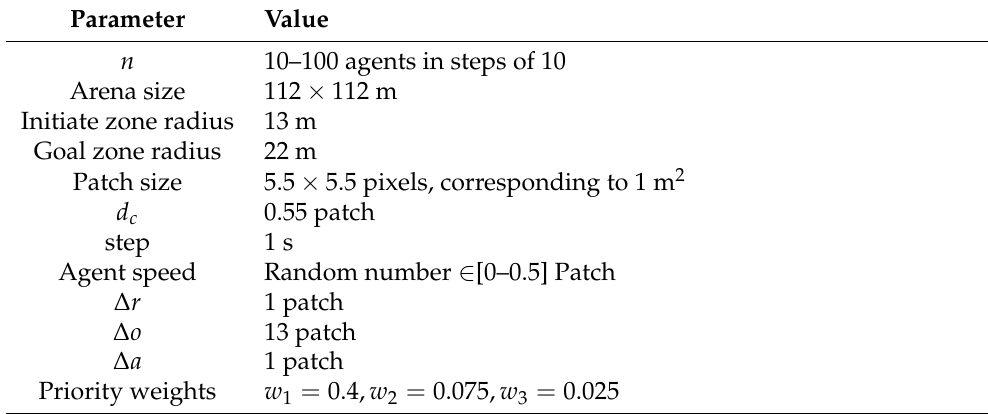
Table 2. Simulation parameter